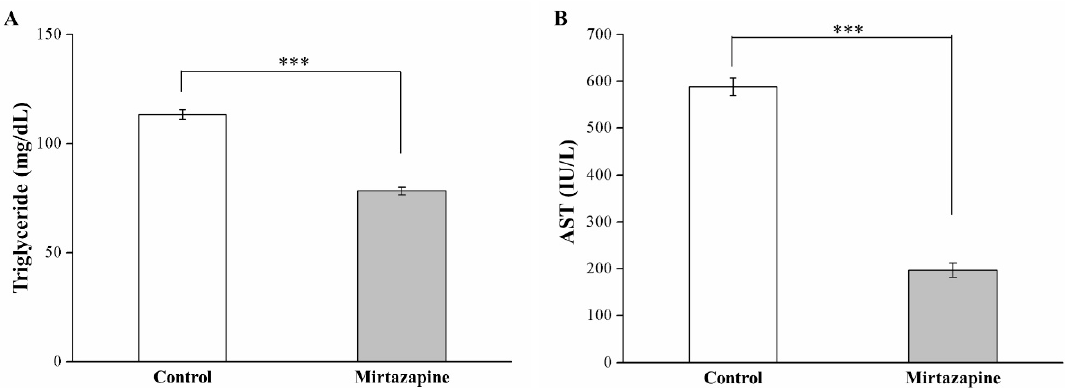
Figure 3. Changes in ( A ) plasma triglyceride and ( B ) aspartate aminotransferase (AST) levels in the control and 10 mg/kg/day mirtazapine-treated mice over the 28 treatment days. All data are presented as mean ± SEMs (n = 10) for both groups. *** p < 0.001.